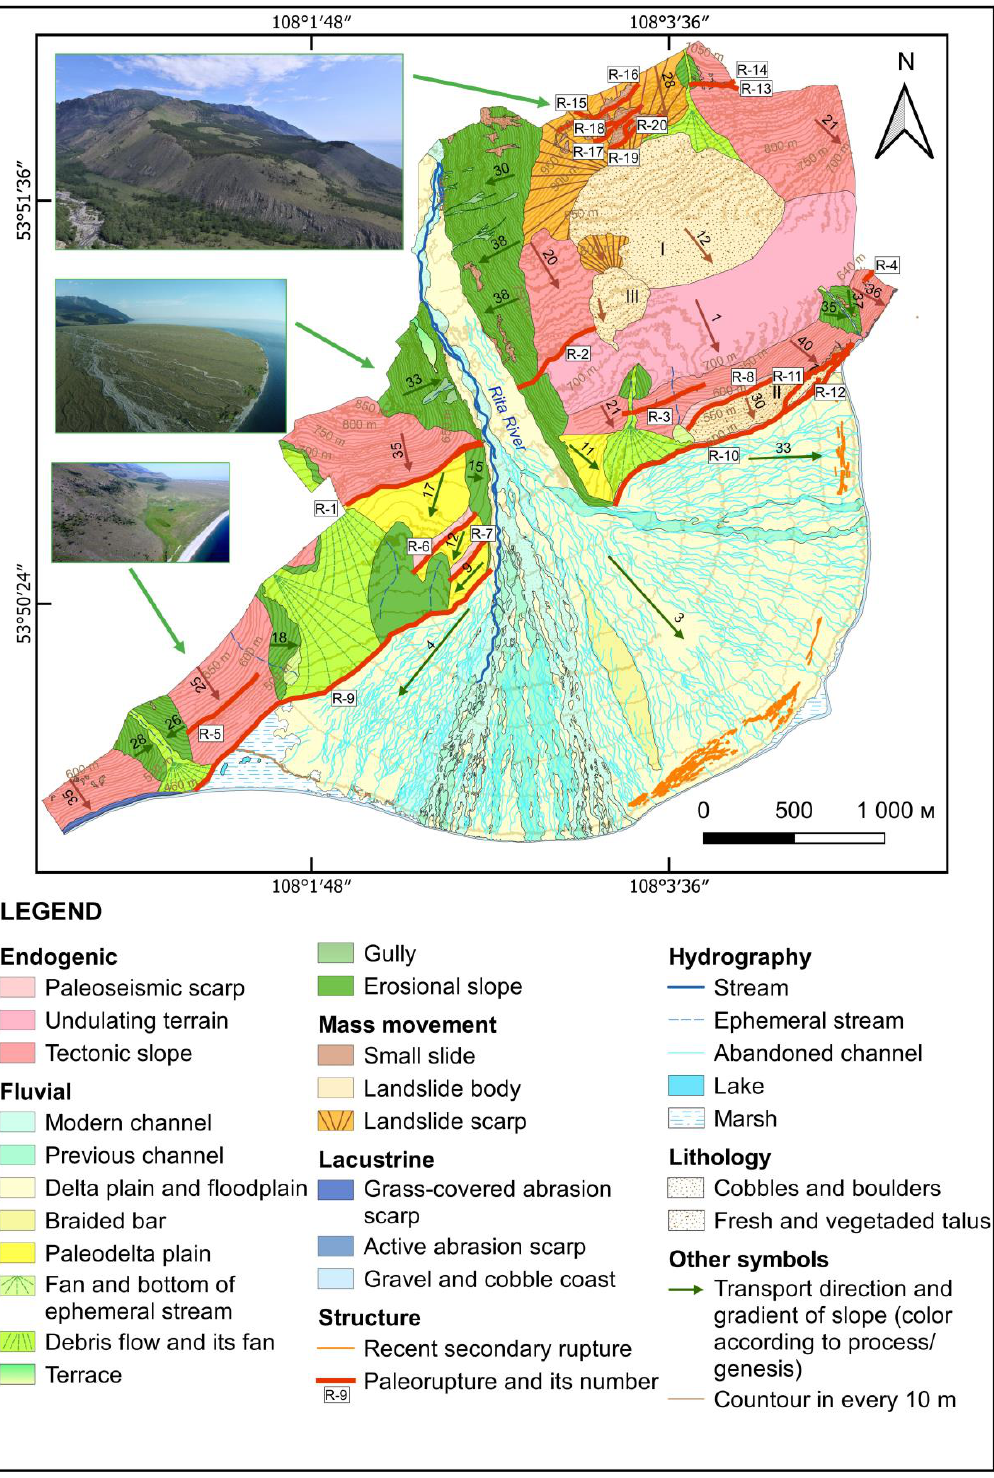
Figure 5. Geomorphological map of the Rita delta and adjacent area.